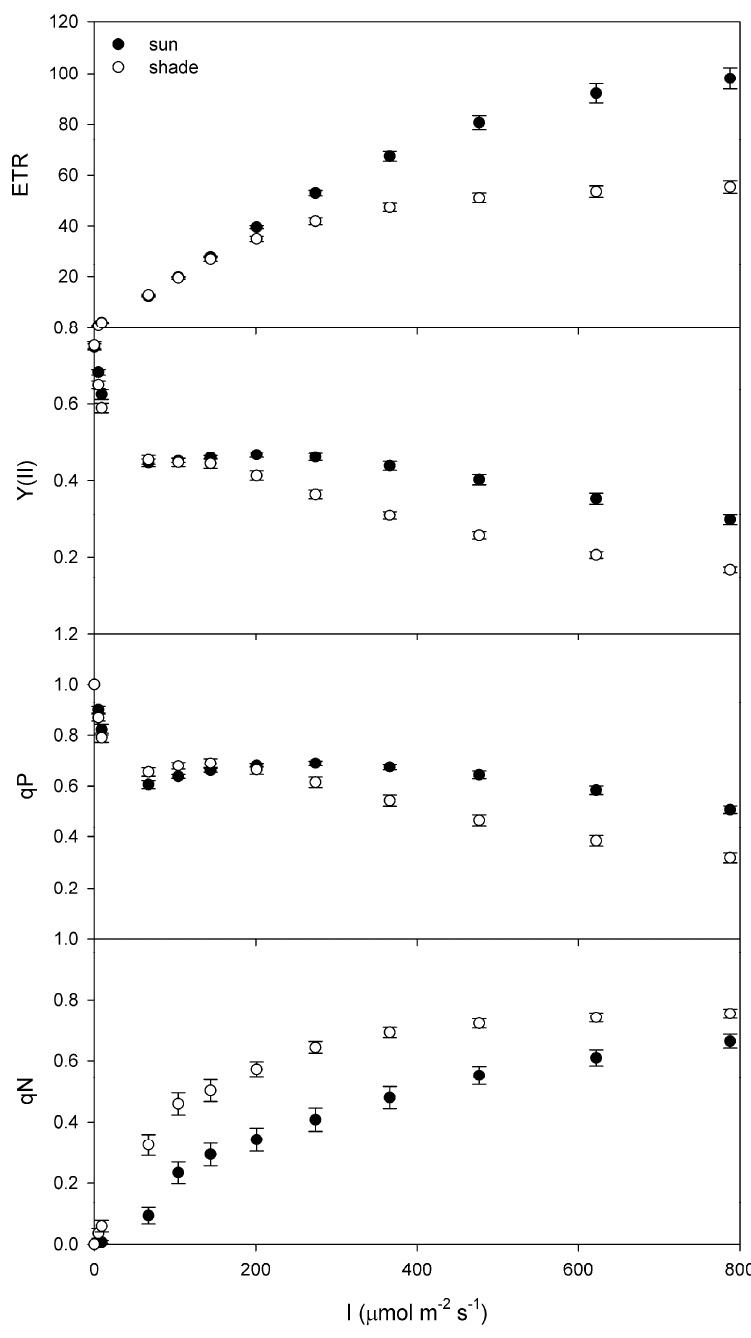
Figure 2. Light curve of photophysiological parameters of the sun (black circles) and shade (open circles) leaves of Phragmites australis . The ± Standard Deviation (SD) ( n = 15) is also indicated for each measurement.